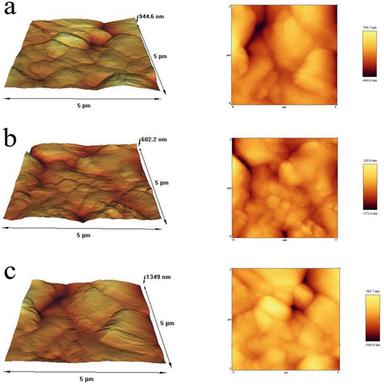
AFM images of sintered membranes: a) M-Z-BFS10 b) M-Z-BFS20, c) M-Z-BFS30.